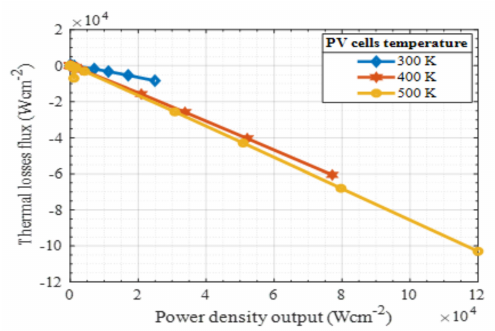
Figure 6. Relationship between power density output and thermal heat flux of the TPV system when the temperature of the TPV cells is at 300, 400, and 500